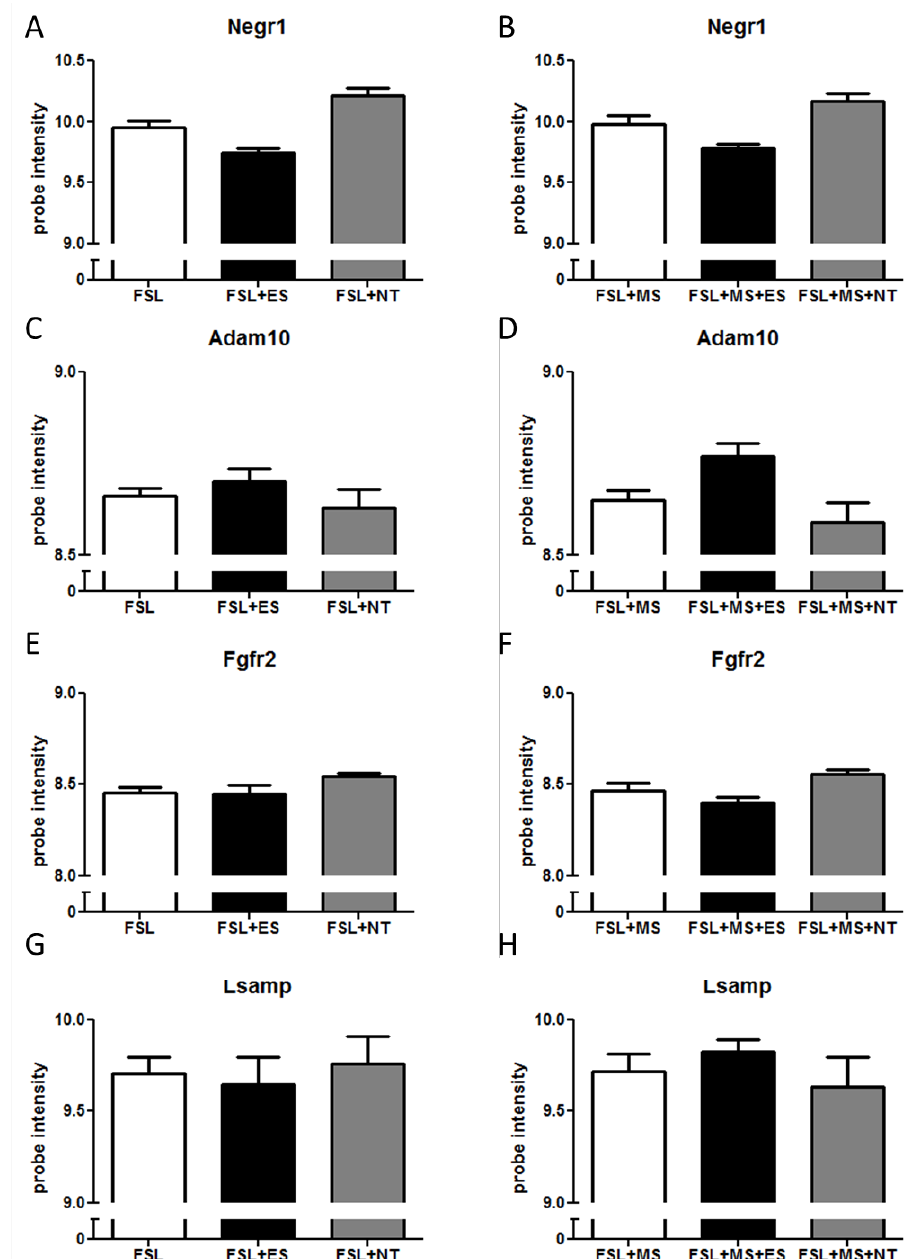
Figure 3. mRNA levels of genes belonging to the Negr1-Fgfr2 pathway in the pre-frontal cortex after ES or NT or vehicle administration. FSL rats were either left undisturbed in their home cage (n-MS, A , C , E , G ) or exposed to MS ( B , D , F , H ) as described in the Methods section. ( A , B ) Negr1 expression; ( C , D ) Adam10 expression; ( E , F ) Fgfr2 expression; and ( G , H ) Lsamp expression. n = 8 – 10.